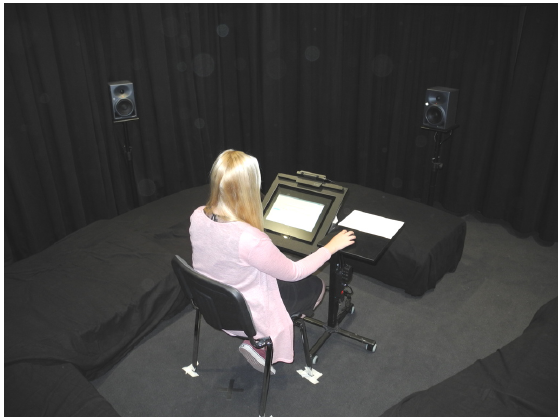
Figure 1. Experimental setup in AuraLab with five loudspeakers and additional porous floor absorbers.